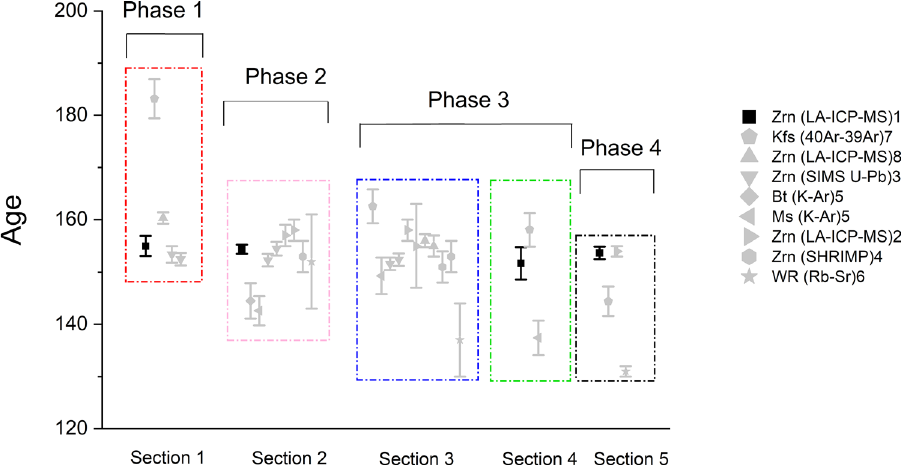
Figure 12. Summary of the dating of the QGC from previous publications and this study. Zrn , Zirco; Kfs, K-feldspar; Bt, Biotite; Ms, Muscovite (Whitney DL and Evans BW et al. 2010) 53 . WR , whole-rock. Reference: 1. This study; 2. Chen et al. 2016 14 ; 3. Guo et al. 2015 27 ; 4. Li et al. 2004 28 ; 5. Yin et al. 2002 29 ; 6. Mao et al. 1998 26 ; 7. Liu et al. 1997 25 ; 8. Chen et al. 2014 13